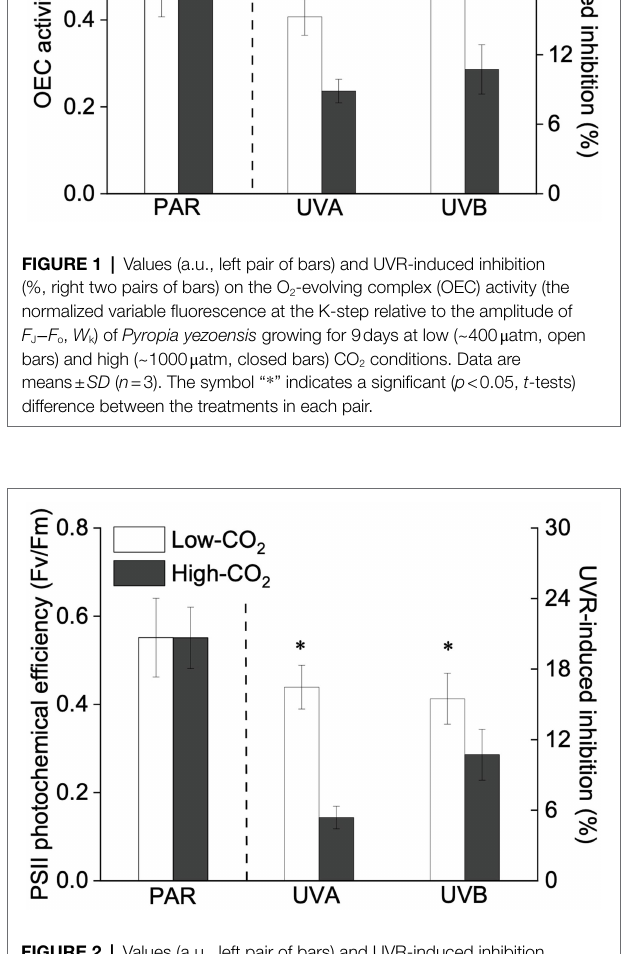
FIGURE 2 | Values (a.u., left pair of bars) and UVR-induced inhibition (%, right two pairs of bars) of PSII photochemical efficiency ( F v / F m ) of P. yezoensis growing for 9 days at low (~400 μ atm, open bars) and high (~1000 μ atm, closed bars) CO 2 conditions. Data are means ± SD ( n = 3). The symbols “ * ” indicates a significant ( p < 0.05, t -tests) difference between the treatments in each